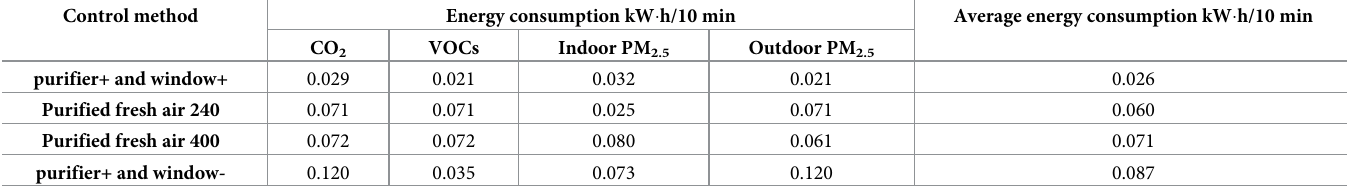
Table 4. Energy consumption levels required by the four control methods under the same IAQ control